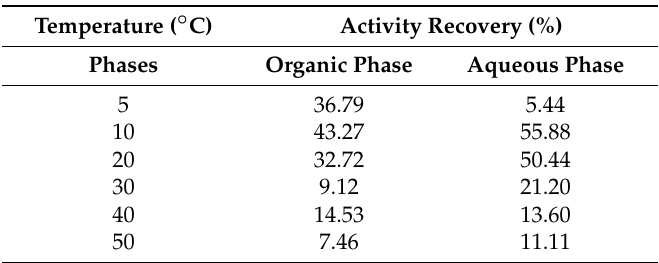
Table 4. Effect of the ionic strength on the forward extraction (organic phase) and the backward extraction (aqueous phase) in the Triton X-100/toluene reverse